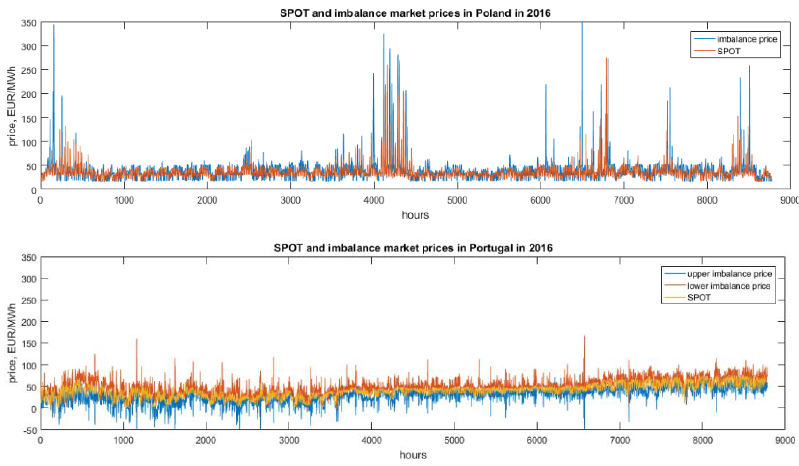
Figure 1. Spot and imbalance market prices in Poland and Portugal in 2016 .